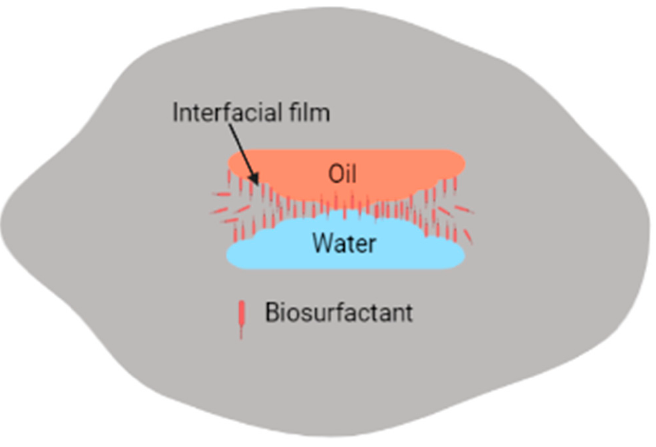
Figure 4. Emulsification of emulsions by biosurfactants.